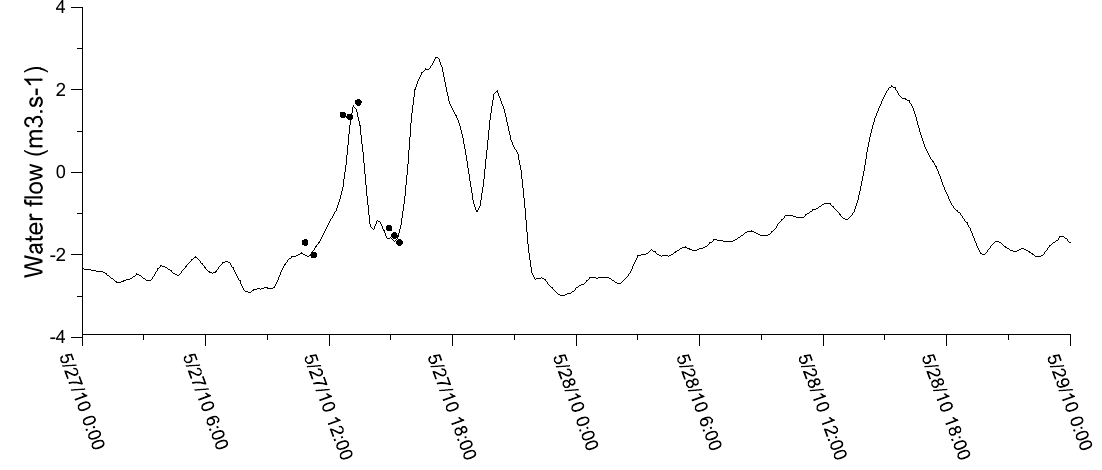
Figure 5. Comparison for Run 1 of measured and simulated discharges in channel C1 (for a water level of 0 mNGF: width 32 m, mean water depth 0.77 m). Modeled water discharges are shown with solid lines and measured discharges with black dots. A positive water flow means an influx of water into the Vaccarès lagoon. The French topographic reference (zero mNGF) was fixed in Marseille at the end of the 19th century by averaging local sea level records between 1885 and 1897